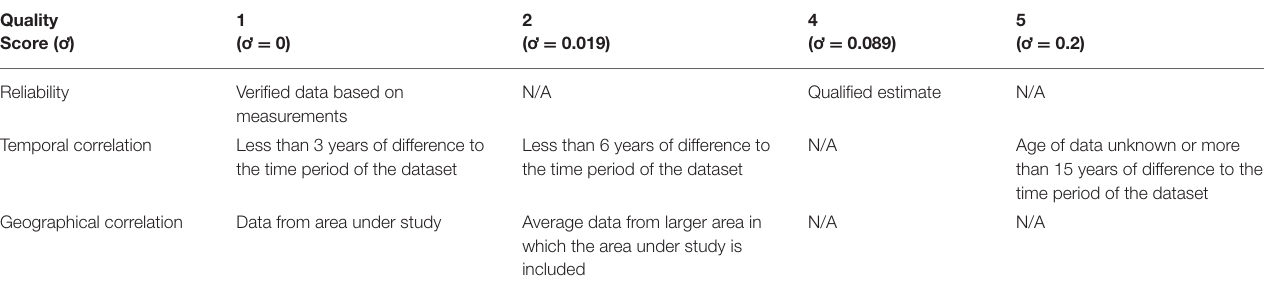
1 (o, = 0) measurements the time period of the dataset